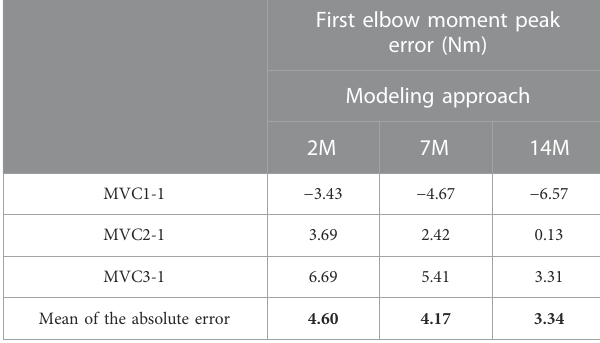
First elbow moment peak error